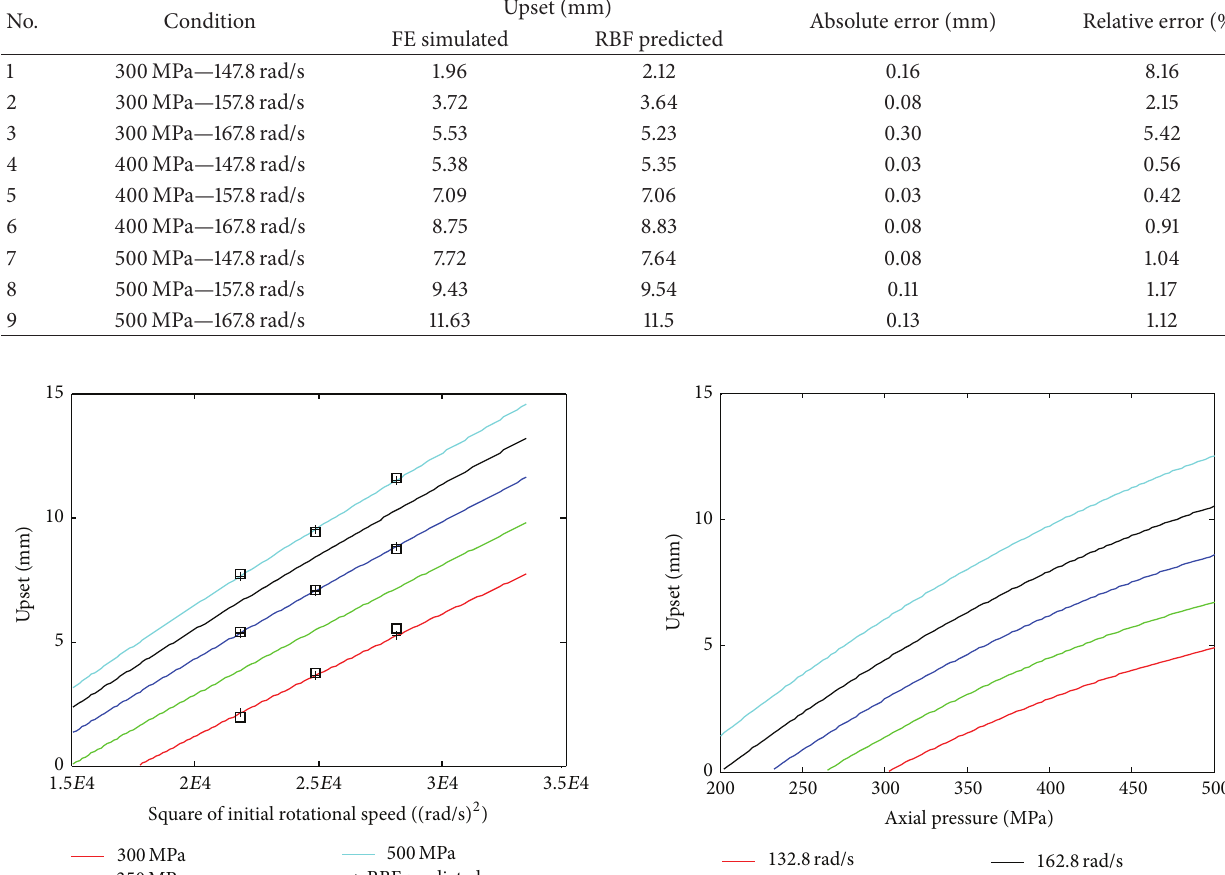
Table 4: Comparison between FE simulated upsets and RBF predicted ones.